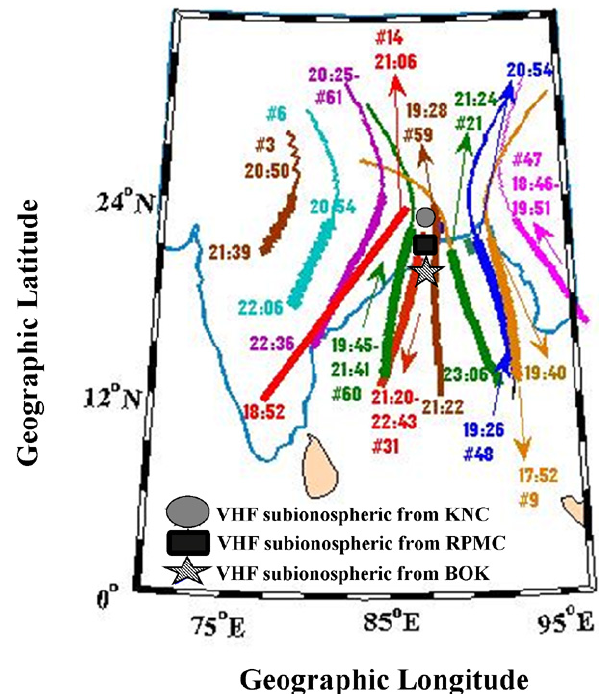
Fig. 9. GPS and GLONASS tracks (geographic) on 20 October 2011 with the bold portions indicating scintillating paths. The initiation and ending time of scintillation are also mentioned. VHF subiono- spheric locations from three stations are shown by three